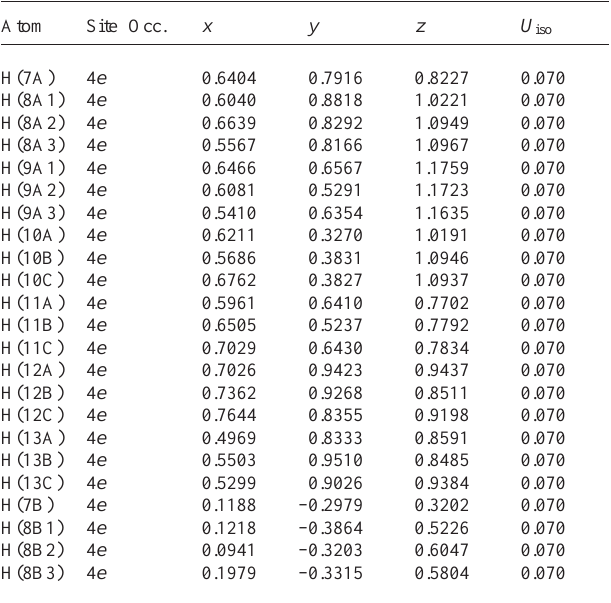
Table 2. Atomic coordinates and displacement parameters (in Å 2 )